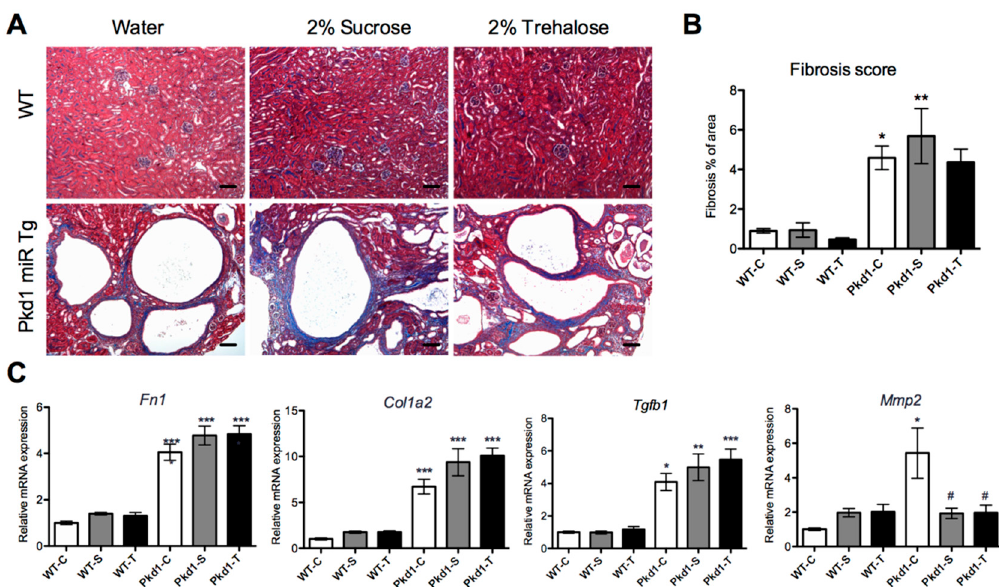
Figure 3. Effect of trehalose treatment on renal fibrosis. ( A ) Representative images and ( B ) quantitative analysis of Masson’s trichrome staining in the renal sections of wild-type and Pkd1 miRTg mice in the different experimental groups ( n = 3, 6, 9, 9, 8, and 7 per group, respectively). Original magnification, 200 × . ( C ) Relative renal mRNA amounts of Fn1, Col1a2 , Tgfb1, and Mmp2. * p < 0.05, ** p < 0.01, *** p < 0.001 compared with the wild-type control group. # p < 0.05 compared with Pkd1 control group. WT, wild-type; PKD, polycystic kidney disease; Tg, transgenic; C, control; S, sucrose; T, trehalose. Scale bar, 50 μ m.